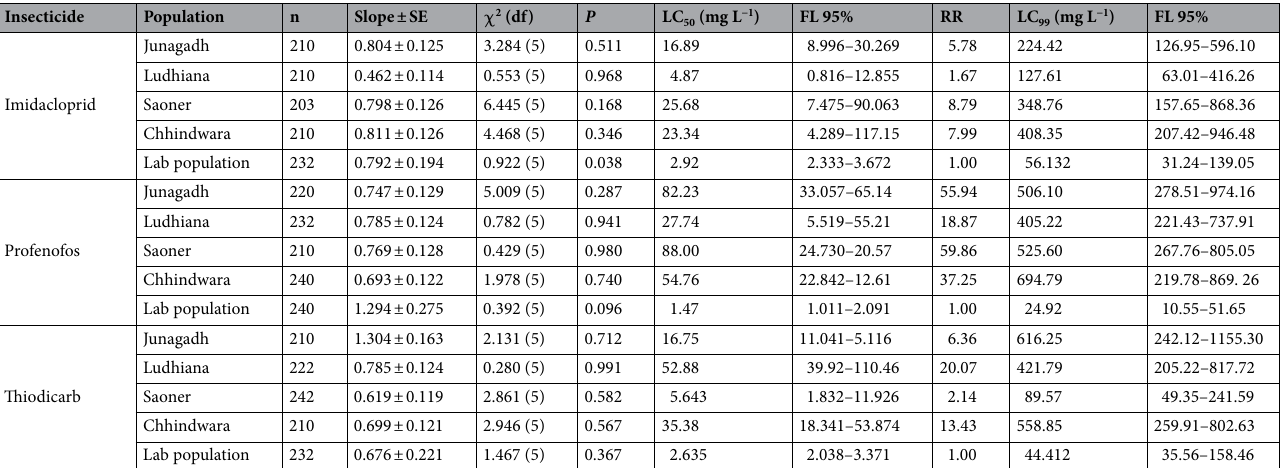
Table 2. Log-dose probit estimated data of imidacloprid, profenofos and thiodicarb against field populations of Phenacoccus solenopsis . n, number of insects tested; SE, Standard Error; χ 2 , chi-square testing goodness of fit of concentration-mortality response; df, Degrees of freedom; LC in mg L −1 , Lethal Concentration; FL, Fiducial Limits; Relative Resistance (RR) = LC 50 of field collected test population/LC 50 of Laboratory Susceptible